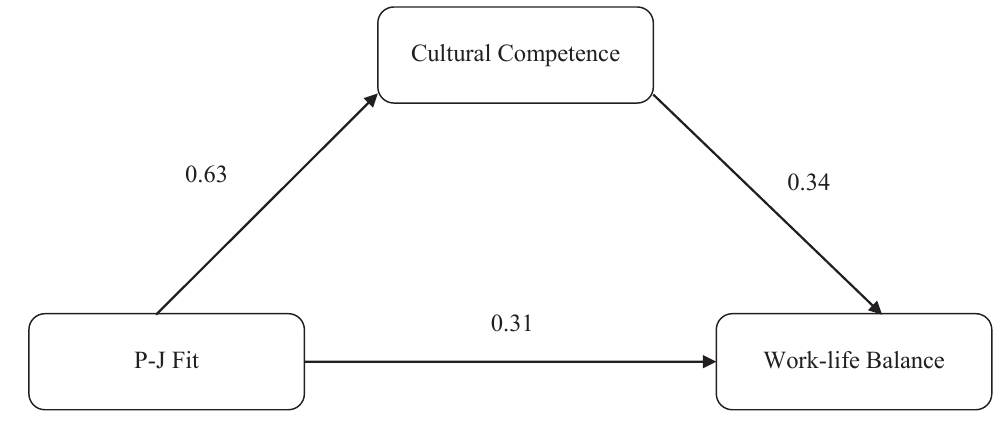
Figure 1. Hypothesized Model of the Mediating effect on the P-J fit–Work-life balance